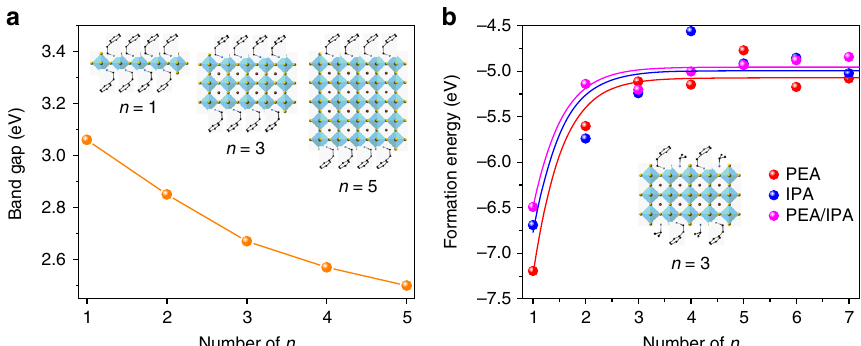
Fig. 1 Bandgap and formation energy calculations of quasi-2D perovskite. a Bandgap of quasi-2D perovskite with different number of layers, n . These values are determined by TA measurement. The inset is the atomic model of the quasi-2D perovskite with n = 1, 3, and 5. b Calculated formation energy of PEABr, IPABr, and their mixed quasi-2D perovskites with different n value. The inset is an atomic model of the PEA/IPA mixed quasi-2D perovskite with n =